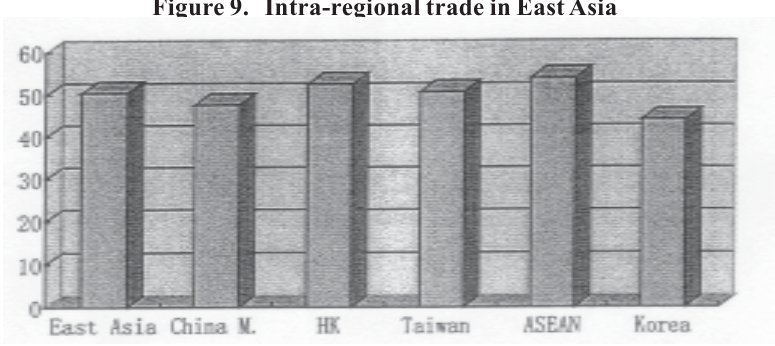
Figure 9. Intra-regional trade in East